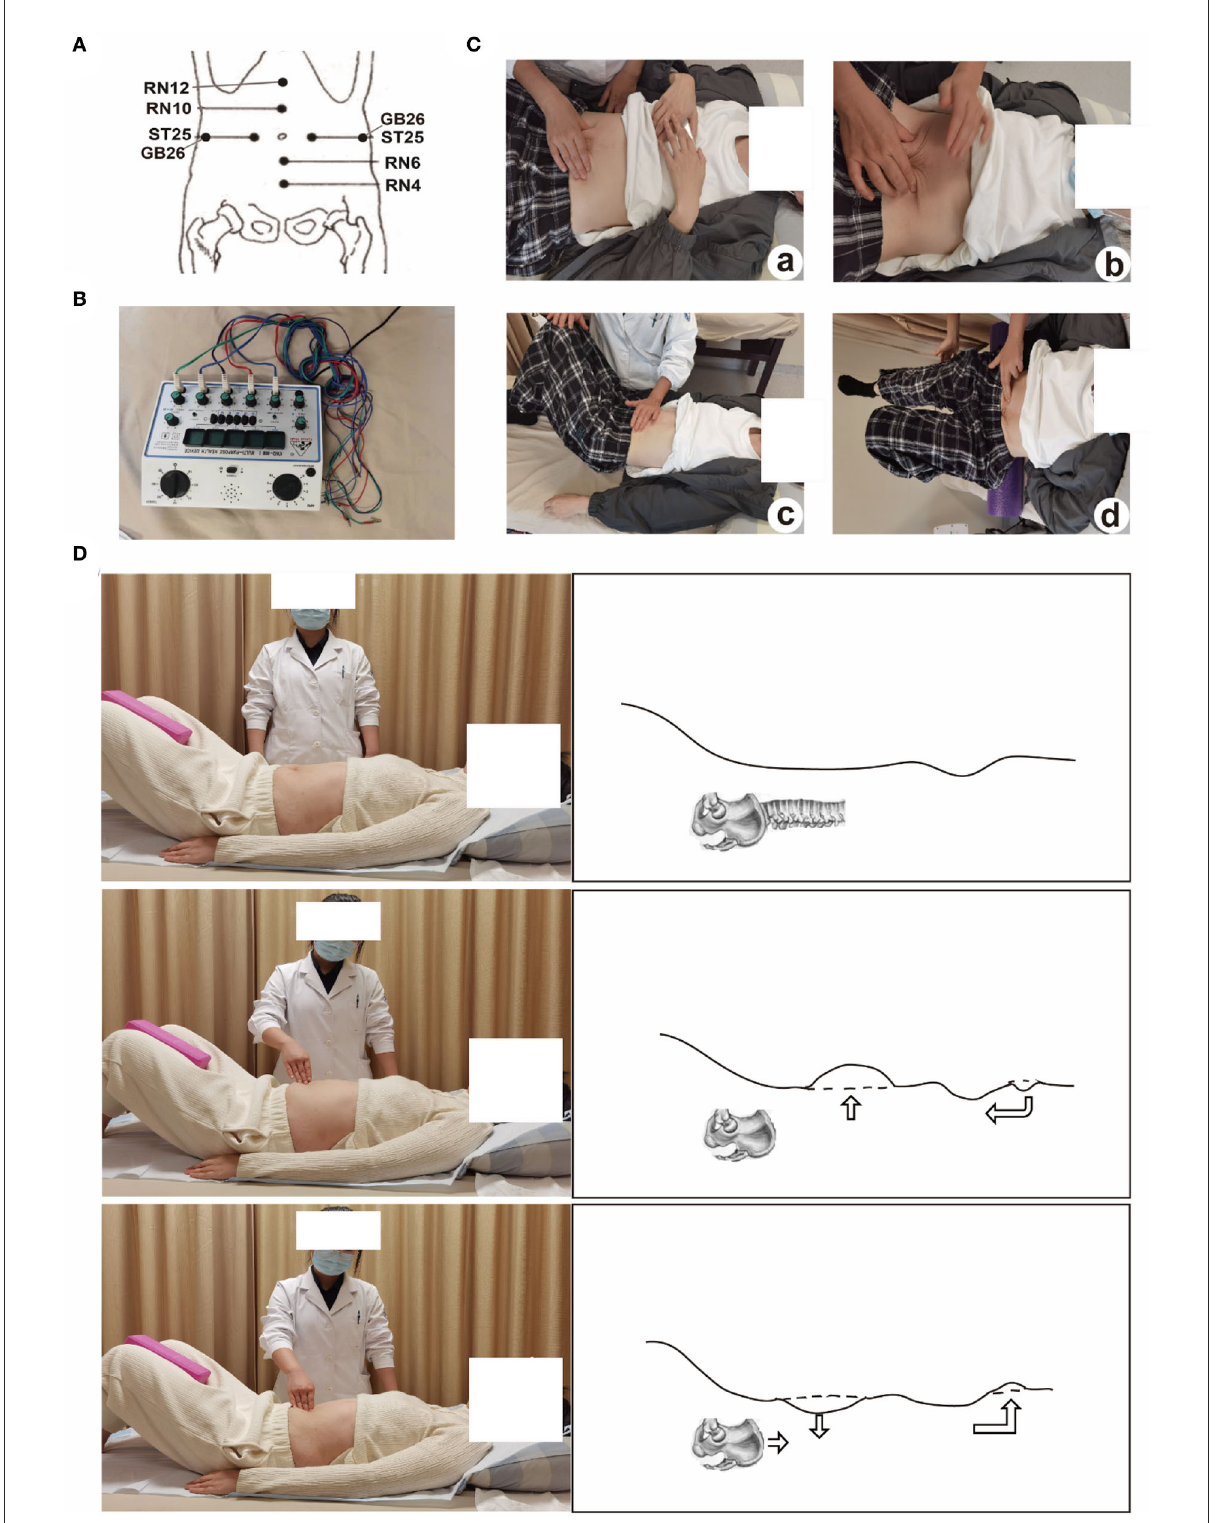
FIGURE1 (A) the location of the acupoint; (B) the EA instrument Great Wall KWD-808I; (C) the graphic representation of physical exercise; (D) the fascial abdominal breathing at rest (from the authors’ own archives, reprinted with the patient’s